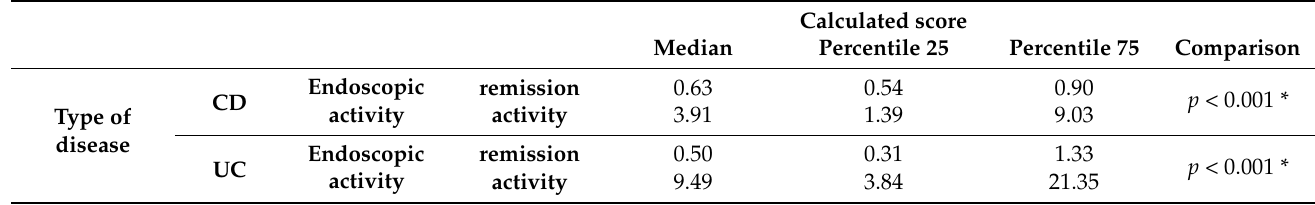
Figure 3. Median values of the activity score calculated for each subcategory of endoscopic activity, in Crohn’s disease and ulcerative colitis. ( ◦ mild outlier, * extreme outlier). Table 7. Description of the activity score according to the degree of endoscopic activity.